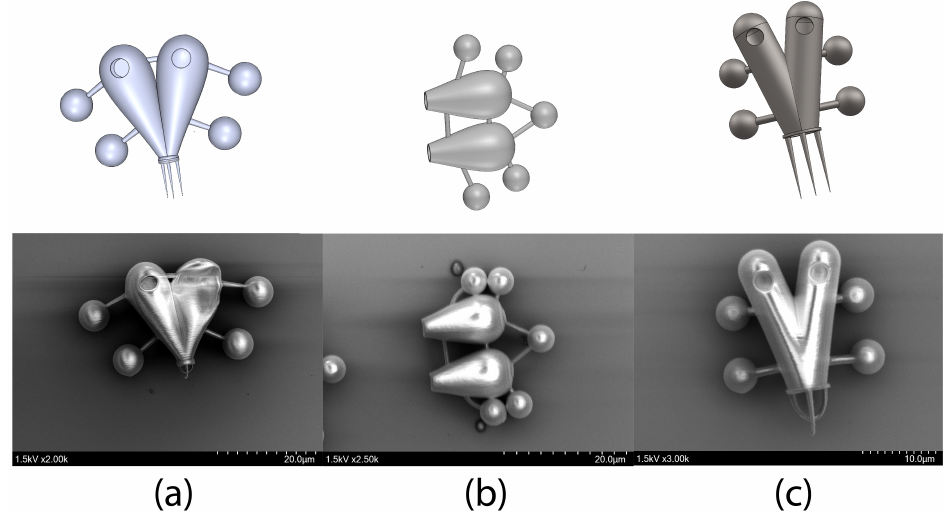
Figure 2. SEM images of fabrication limitations of microbots due to the lack of structural integrity ( a ) One of the two channels got deflated during the development process due to lean wall thickness, ( b ) front control handles got deformed due to the flow instigated during the development process, and ( c ) spikes in front of the microbot got deformed due to the lack of